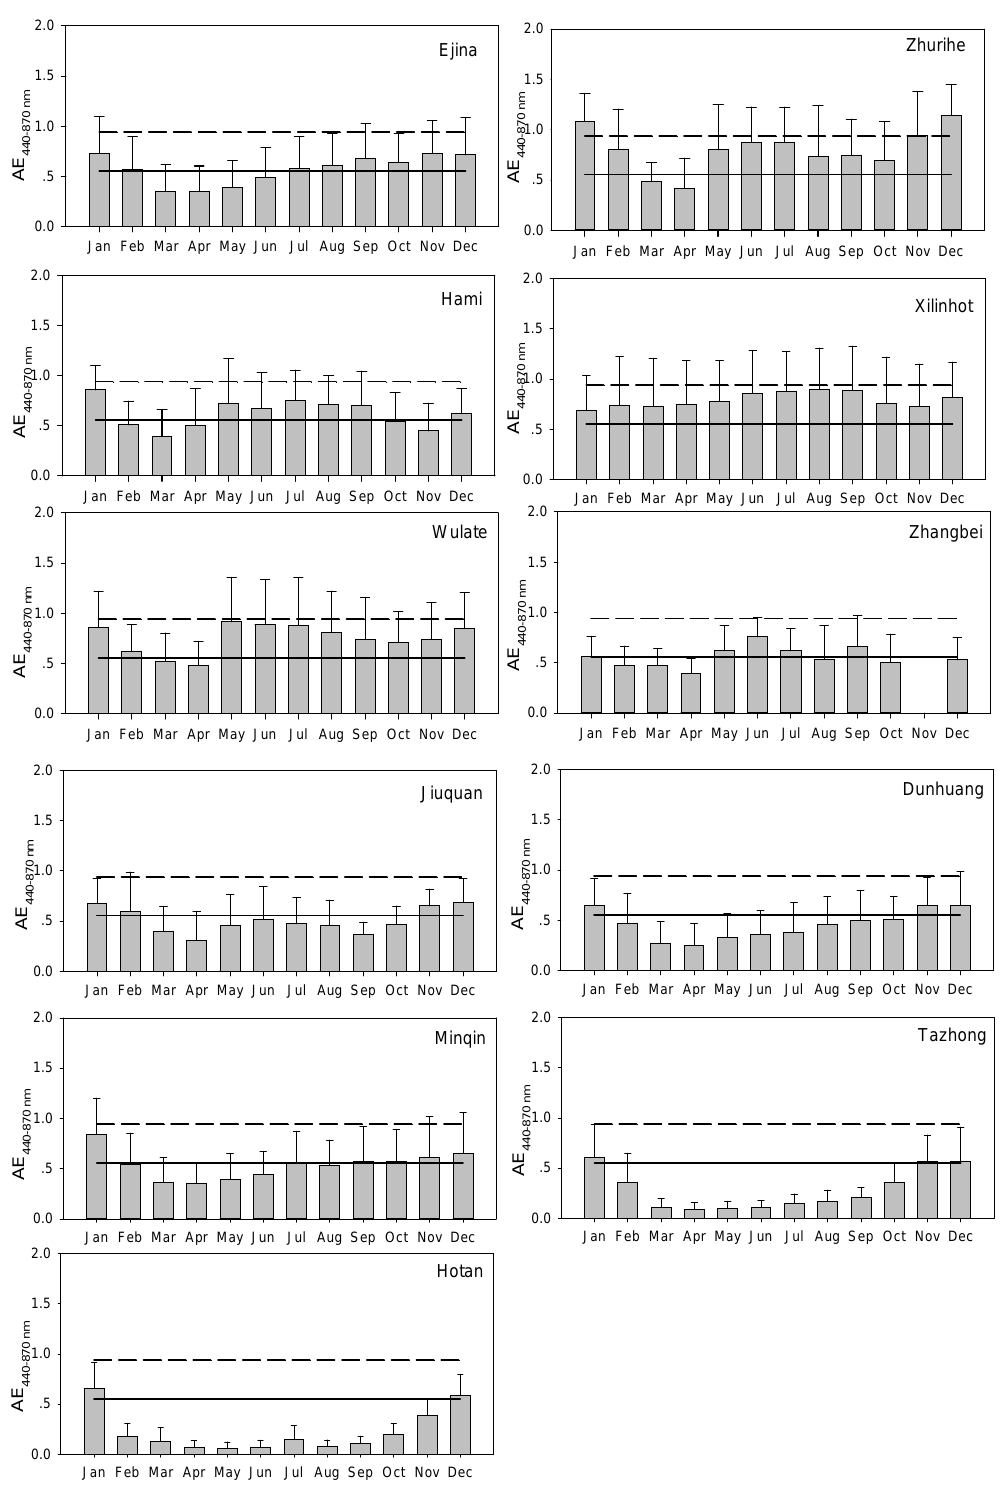
Figure 9. Monthly averaged AEs between 440 and 870nm at rural desert sites. The solid and dash horizontal hairlines indicate the annual averages for the subgroup and the whole database,